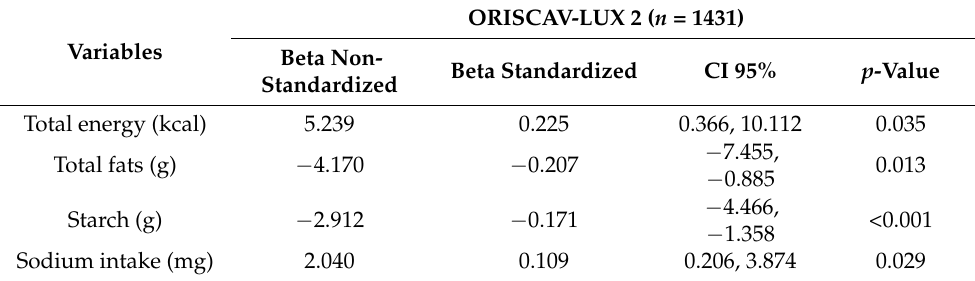
Table 7. Regression coefficients (beta, 95% CI) between nutrient intakes and constipation score based on the linear regression modelling a